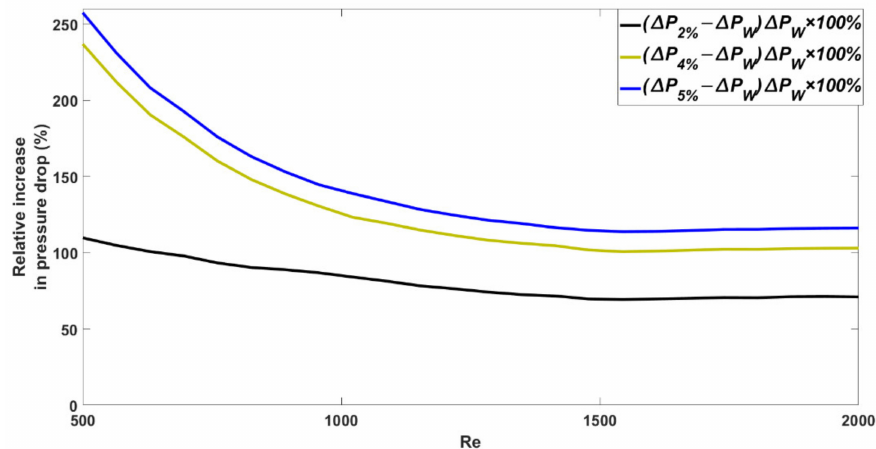
Figure 8. Relative increase in pressure drop with respect to